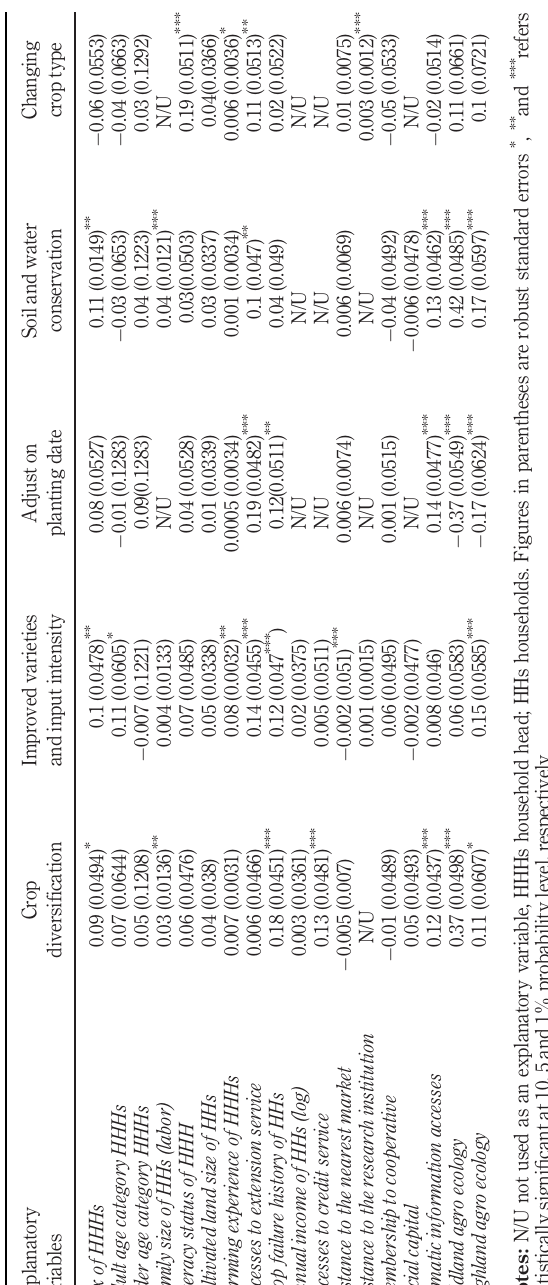
Table 6. Marginal effect because of independent